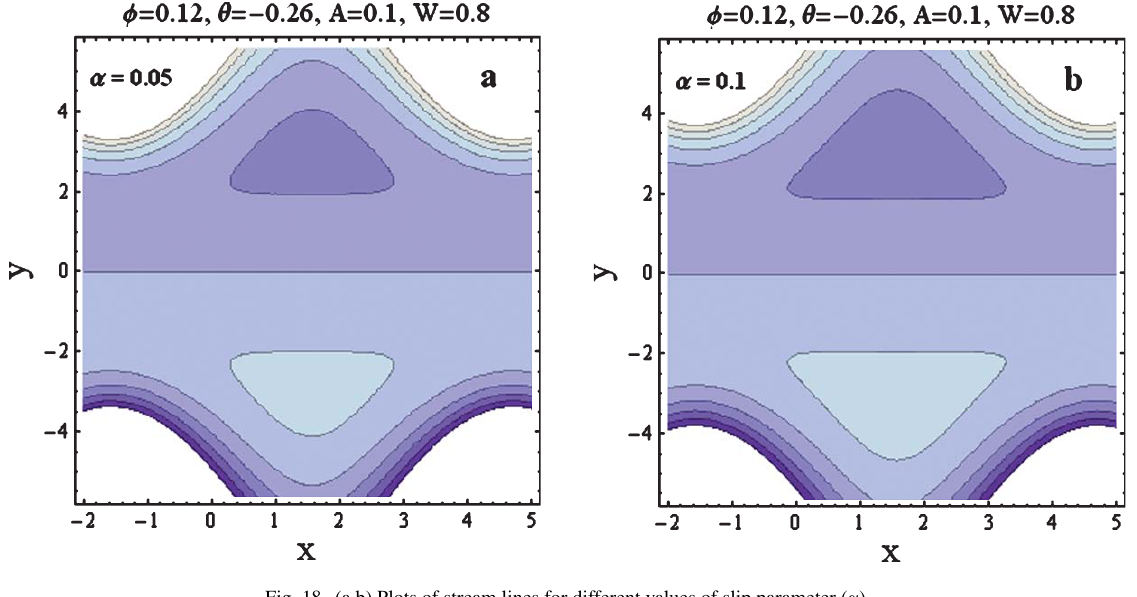
Fig. 18. (a,b) Plots of stream lines for different values of slip parameter ( α ).